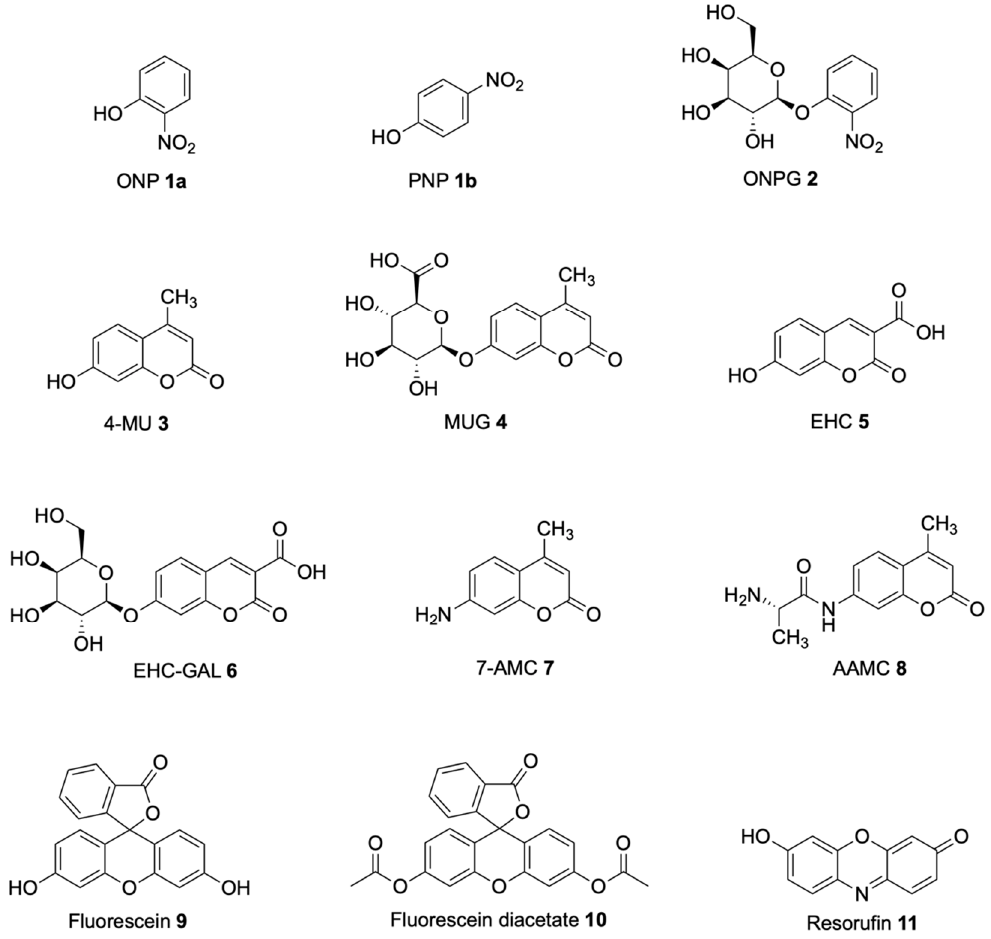
Figure 2. Chemical structures of signalophors ( 1 , 3 , 5 , 7 – 9 , 11 ) and of modified enzyme substrates ( 2 , 4 , 6 , 10 ).